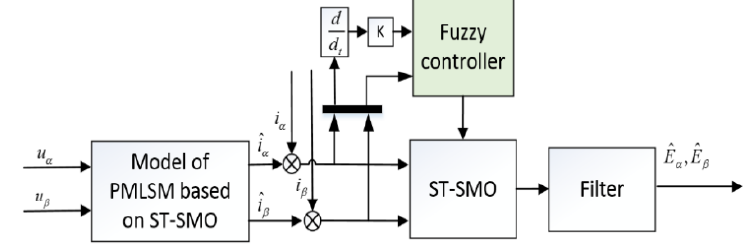
Figure 2. F-ST-SMO algorithm implementation diagram.